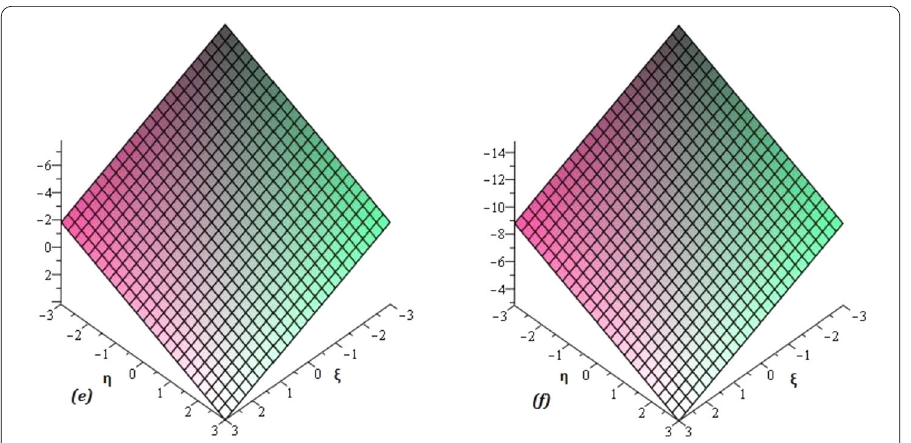
Figure 3 The plot of u solution of Example 1 at ( e ) β = 0.75 and ( f ) 0.50